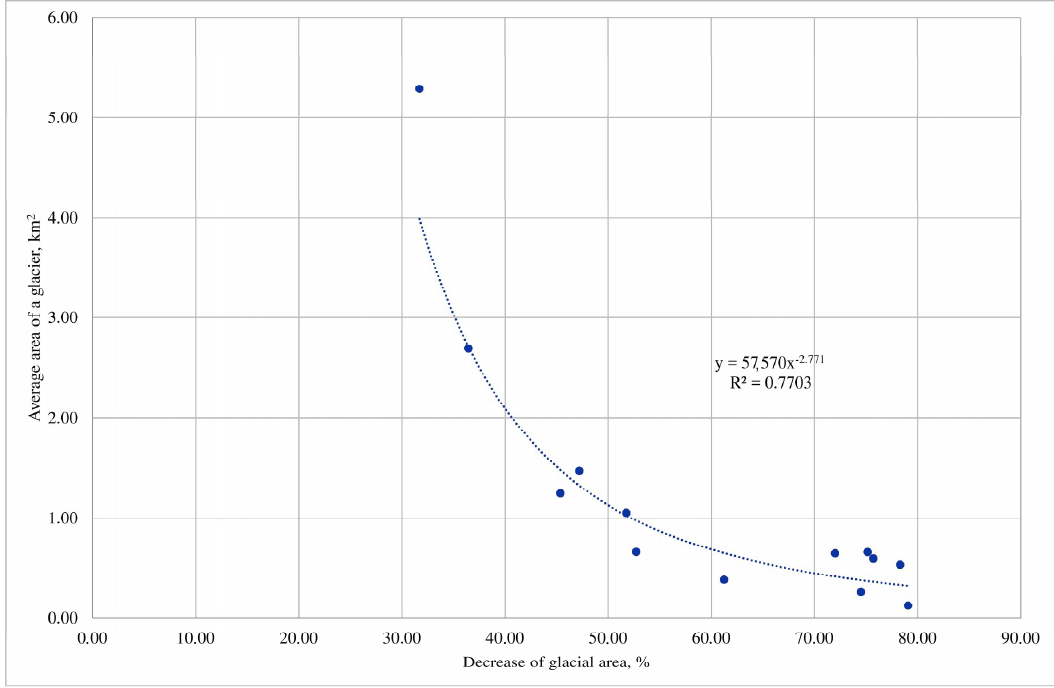
Figure 15. Relationship between the average area of the glaciers in different river basins of Tavan Bogd at the LIA peak and glacial reduction (%) between the LIA peak and 2010.